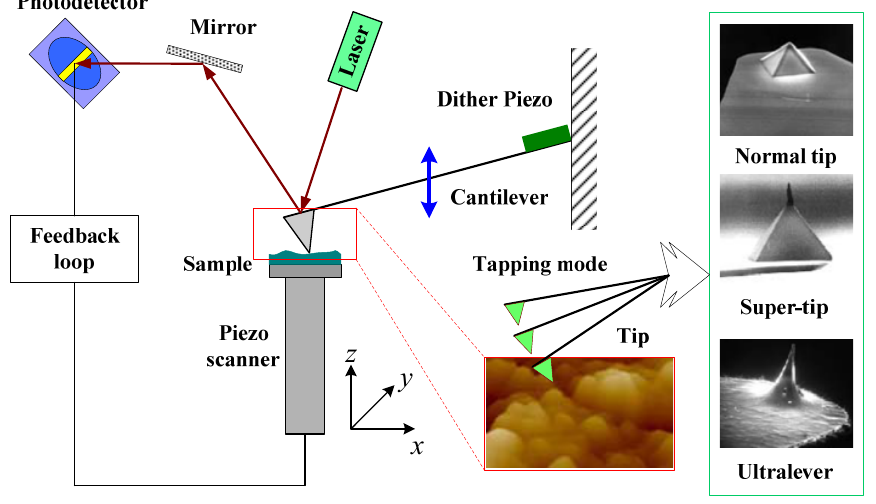
Figure 1. Schematic of the typical TM-AFM